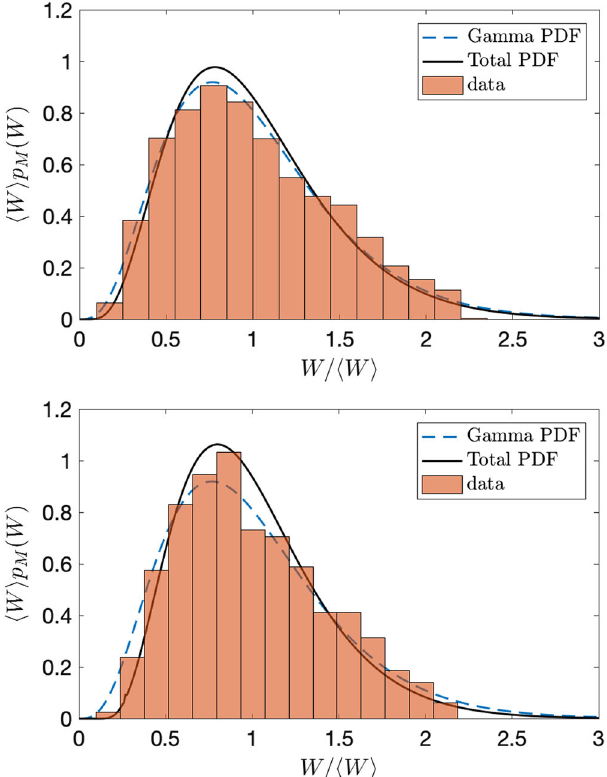
FIG. 8. Histograms of the measured SXRSS spectrum from LCLS within a Δ ω ¼ 1 . 1 eV window (top) and a Δ ω ¼ 7 . 5 eV window (bottom). The dashed line denotes a gamma PDF [Eq. (16)] of a pure seed (no SASE background) with M ¼ M ¼ 4 . 3 , as given by FIG. 7. The solid line is the 1 prediction from the total PDF in Eq. (18) that includes the SASE contribution. Within the narrow window (top) the measured SASE portion is small ( h W 0 i = h W 1 i ¼ 6 . 4% , M 0 ¼ 16 ), so the two PDFs are nearly identical. Within the larger window, however, the larger SASE contribution ( h W 0 i = h W 1 i ¼ 15 . 7% , M Eq. (18) is qualitatively a better fit to the SXRSS